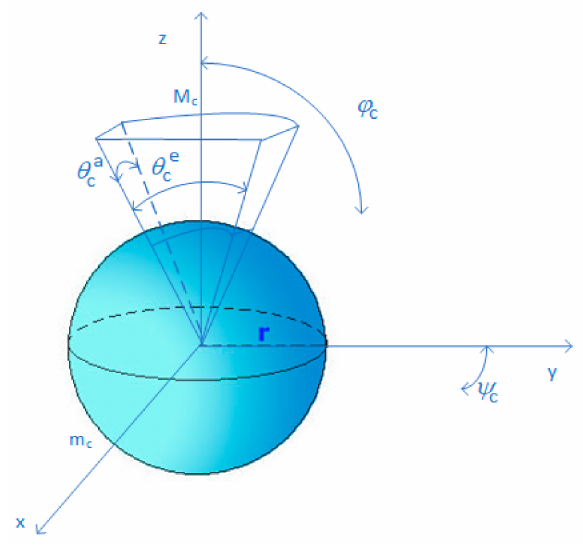
Figure 2. Sectorized antenna